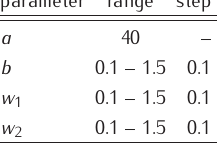
This is the case where three loudspeakers were located at (0. 90. -90). This shows the results for the parameters and w 1 w 2